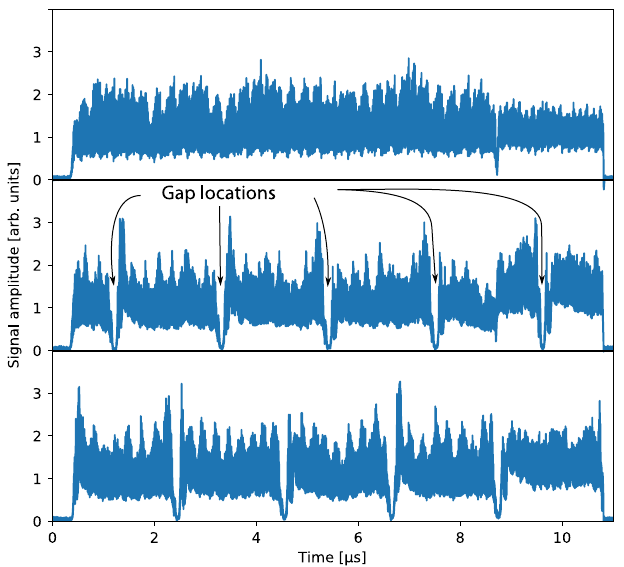
FIG. 7. Examples of the longitudinal beam structure measured in the transfer line without a barrier bucket (top), with an asynchronous barrier bucket (middle), and with a synchronous barrier bucket (bottom) compared to the rise of the PS extraction kickers. The 200 MHz modulation is clearly visible.